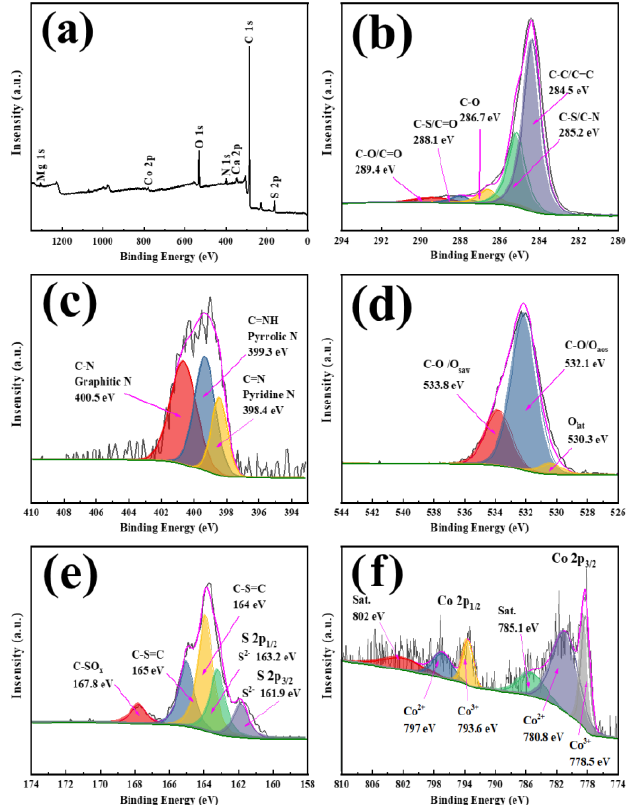
Figure 4. XPS diagram of the main elements of cobalt-doped carbon sphere material, full spectrum of elements ( a ); C 1 s ( b ); N 1 s ( c ); O 1 s (d); S 2p ( e ); Co 2p ( f ).